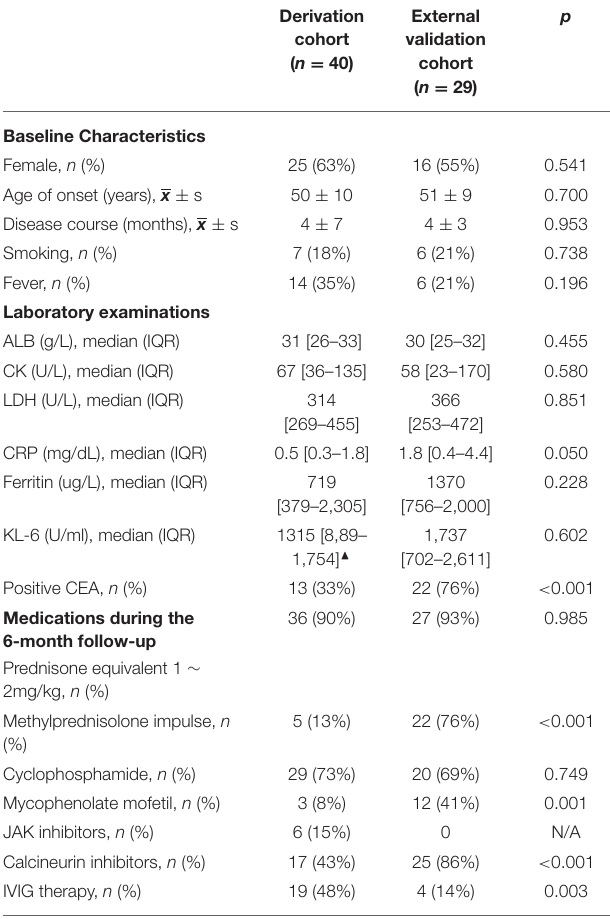
TABLE 5 | Comparison of baseline characteristics and medications between two cohorts of patients with anti-MDA5-positive DM. Derivation